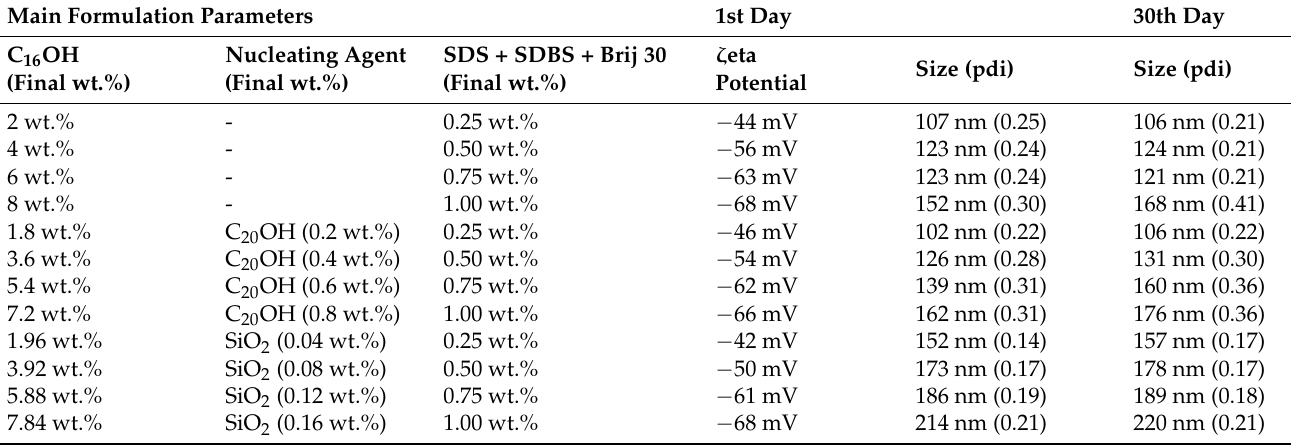
Table 1. ζ eta potentials † , hydrodynamic diameters * and polydispersity indices (pdi) of cetyl alcohol-in-water nanoemulsions at 298.15 K ‡ .